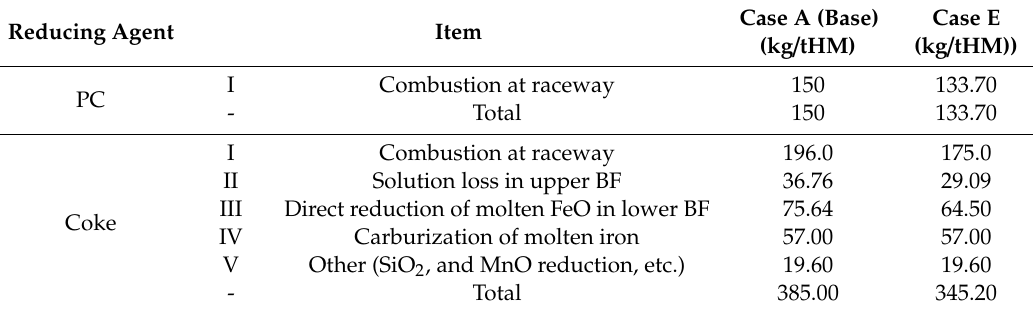
Table 9. Reducing agent rate in cases A and